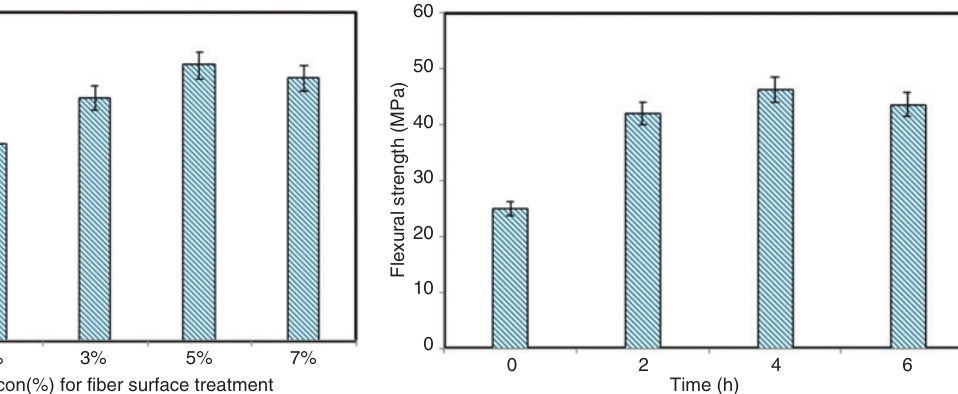
Figure 4: Effect of alkali treatment on the flexural strength of the LCF epoxy composite.